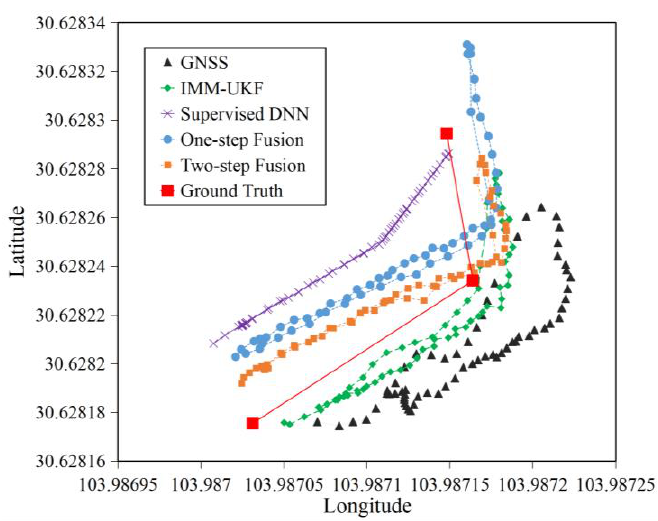
Figure 11. Location distributions when the target person walked around a corner in Scenario 3.